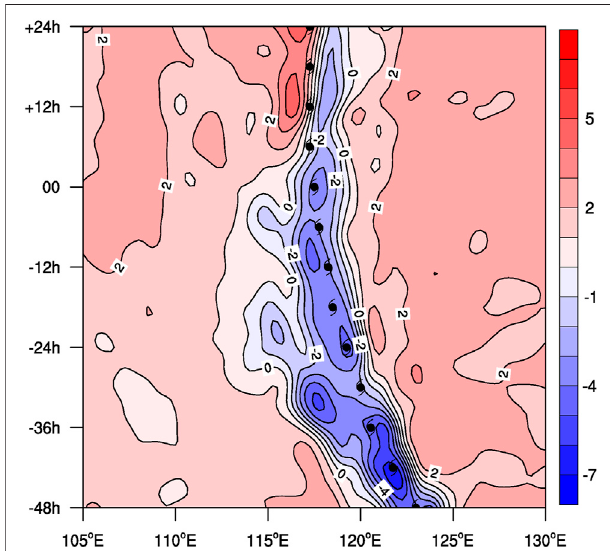
FIGURE 6 | The latitudinal time variation of divergence averaged between 850 and 975-hPa and meridional winds averaged between 925 and 975-hPa across the TC center. (Contour indicates meridional wind speeds, Unit: m s − 1 , shaded area denotes divergence, Unit: 10 − 5 s − 1 , and symbol markers indicate the typhoon center